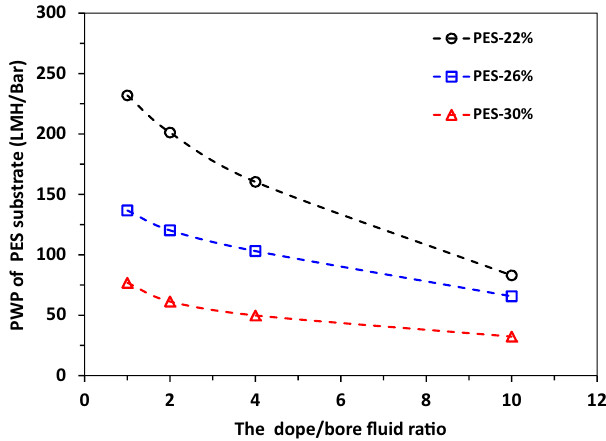
Fig. 4 Pure water permeance (PWP) of the PES hollow fi ber membrane substrates. The PWP measurement was conducted at a transmembrane pressure of 1 bar.